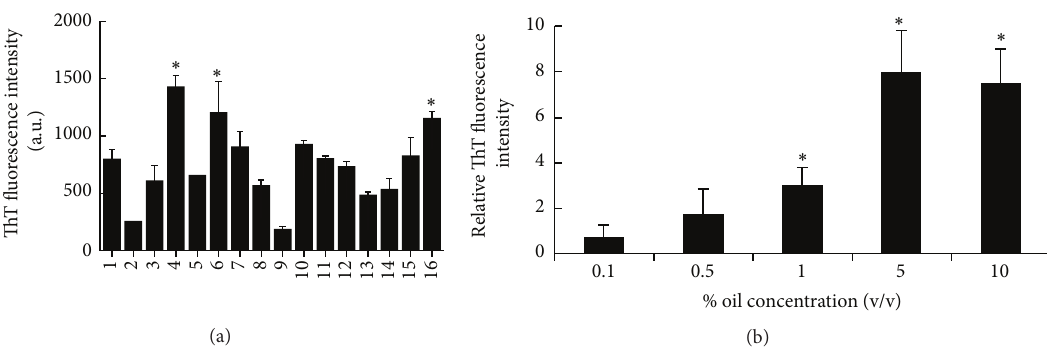
Figure 1: Effects of essential oils on the fibrillation of 𝛼 -Syn assessing with ThT fluorescence assay at 482 nm wavelength. (a) 𝛼 -Syn (70 𝜇 M) was incubated at 37 ∘ C, pH 7.4, for 24 hours either (1) alone or in the presence of 1% (v/v) of (2) Ferula gummosa , (3) Eucalyptus globulus , (4) Myrtus communis (Myrtle), (5) Satureja hortensis , (6) Rosmarinus officinalis (Rosemary), (7) Mentha spicata (Spearmint), (8) Mentha piperita (Peppermint), (9) Cuminum cyminum (Cumin), (10) Artemisia dracunculus (Tarragon), (11) Citrus sinensis (Orange), (12) Citrus limonum (Lemon), (13) Thymus vulgaris (Thyme), (14) Lavandula officinalis (Lavender), (15) Mentha pulegium (Pennyroyal), and (16) Foeniculum vulgare (Fennel). (b) 𝛼 -Syn (70 𝜇 M) was incubated as same as (a) in the presence of different concentrations of Myrtus communis. Each value represents the mean ± SD ( 𝑛 = 3 ). ∗ 𝑃 < 0.05 (one-way ANOVA) indicated the samples are significantly different from the control.